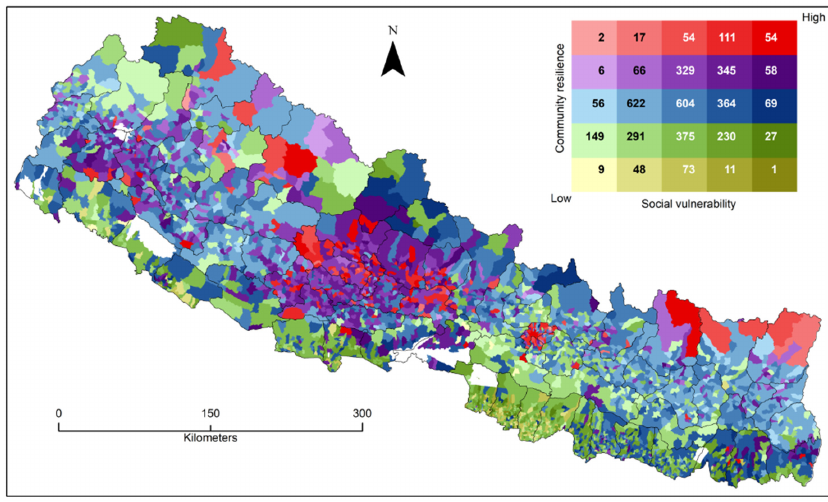
Figure 5. Bivariate map (5x5 categories) depicting social vulnerability (SoVI) and community disaster resilience (CDRI) at the village level. Numbers (in legend) indicate a count of villages in each vulnerability/resilience category.